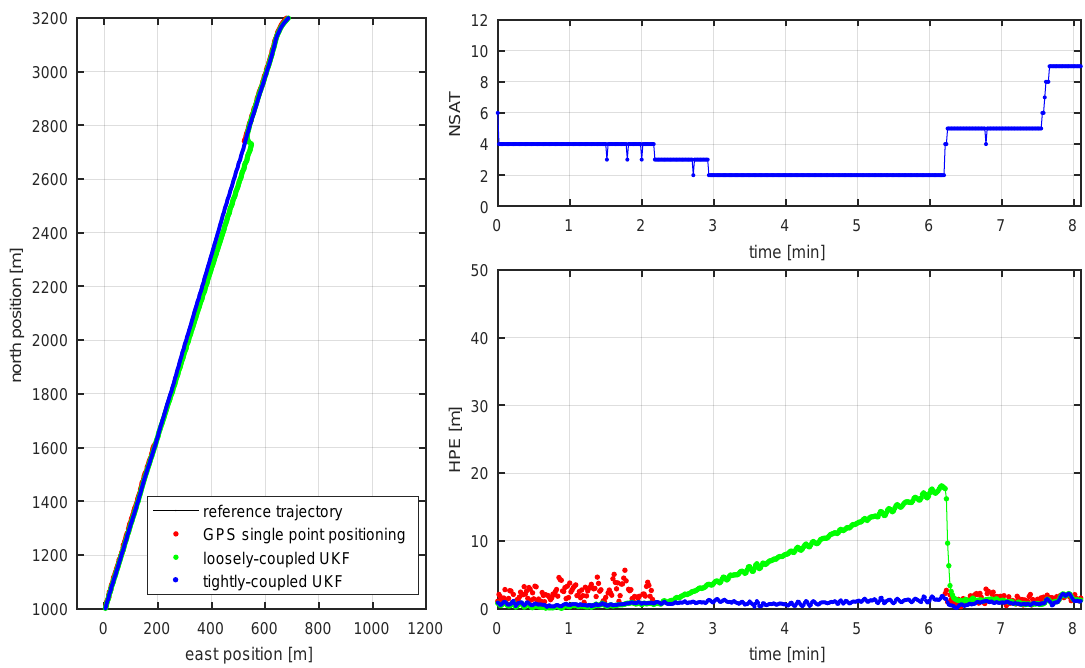
Figure 11. An example of the performance of the hybrid IMU/GNNS/DVL system during the time when fewer than four satellites are available: segment overview ( left ); number of available satellites ( top right ); and the HPE ( bottom right ).